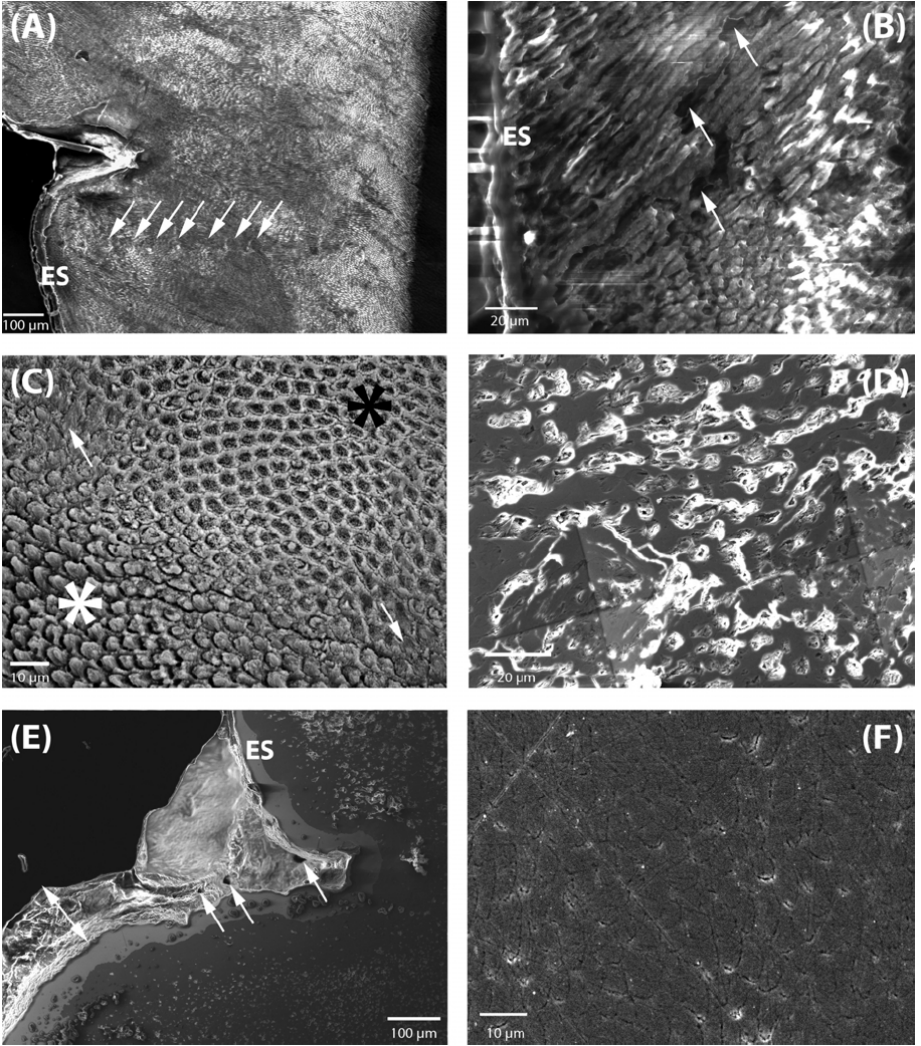
Fig.4 Enamel microstructure of AI samples, on which microhardness was measured, was viewed by SEM. (A) Pitted hypoplastic AI enamel (second right deciduous maxillary molar) was of normal thickness with twisted prisms course in the bulk of enamel. An ob- vious pit is present on the enamel surface. Indentations of microhardness measurements (underlined) can be seen (etched, 110 × ). (B) Smooth hypoplastic AI enamel (second right deciduous mandible incisor) was not only exceptionally thin but also of poor mi- crostructure. Between deficiently formed and inadequately mineralized prisms, empty spaces the size of prisms were present, some of which are marked with arrows (etched, 650 × ). (C) Hypomaturated AI (right deciduous maxillary canine; tooth 53-B in Table 1) revealed areas with etched prism heads and less-etched preserved sheath spaces (black asterisk). In other areas, the situation was reversed, with prism heads being preserved (white asterisk). There were some areas where the prism structure was poorly defined or even unrecognizable (arrows) (etched, 1000 × ). (D) Two indentations of